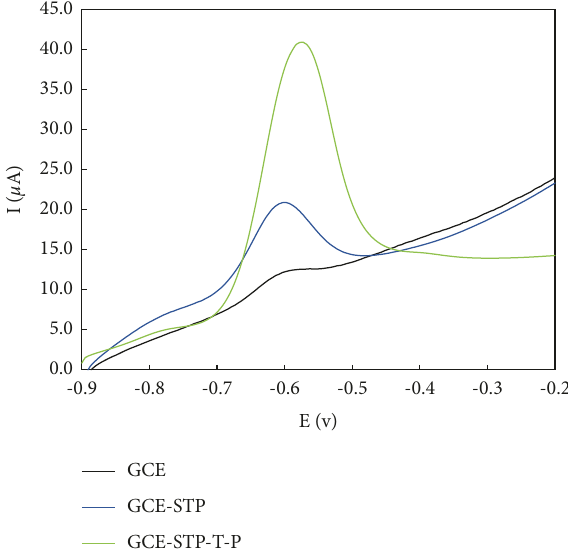
Figure 6: Electrochemical performance of bare and modified GCE with STP and STP-T-P via SWV technique.